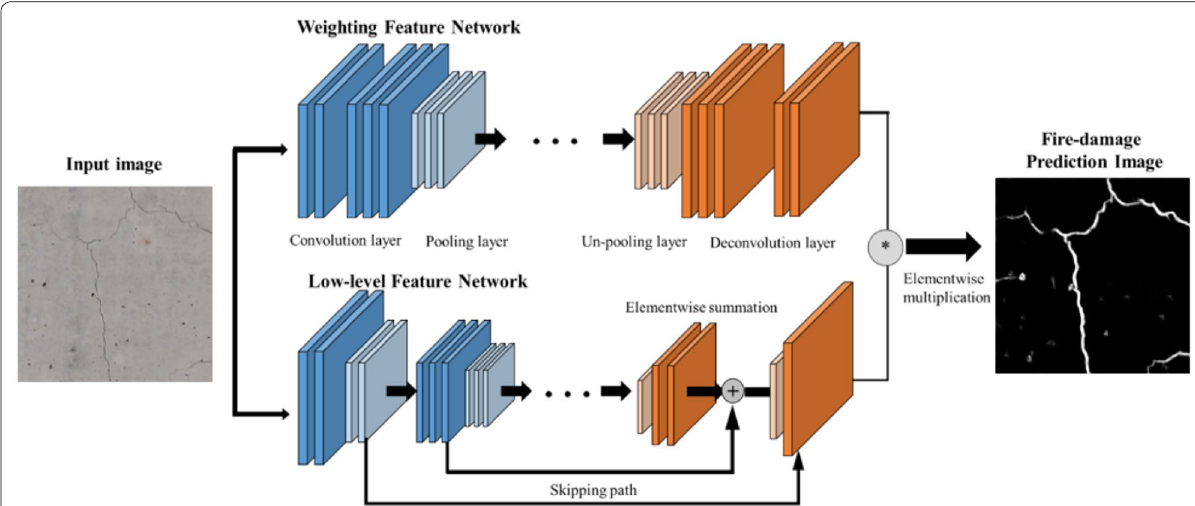
Fig. 5 Crack detection algorithm based on two-streamed convolutional neural networks using weighting feature network and low-level feature network. (color figure